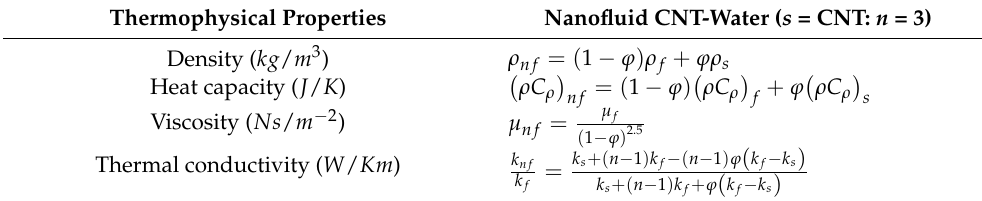
Table 1. The effective thermophysical properties of nanofluid.